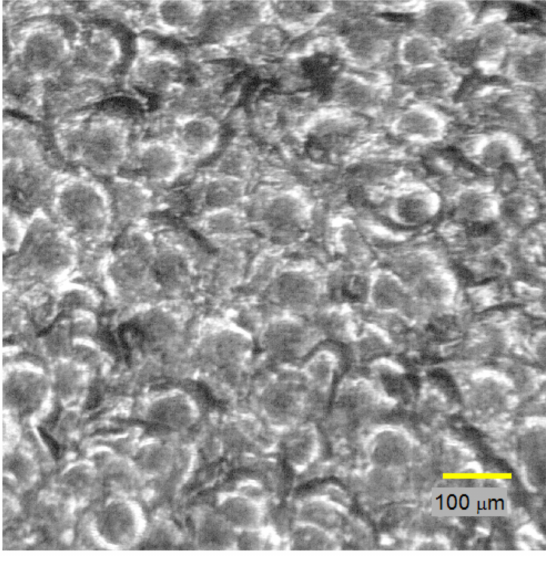
Figure 6. Example of a low-intensity shot-peened metal, of size 0.8 mm 2 , i.e., 1653 × 1653